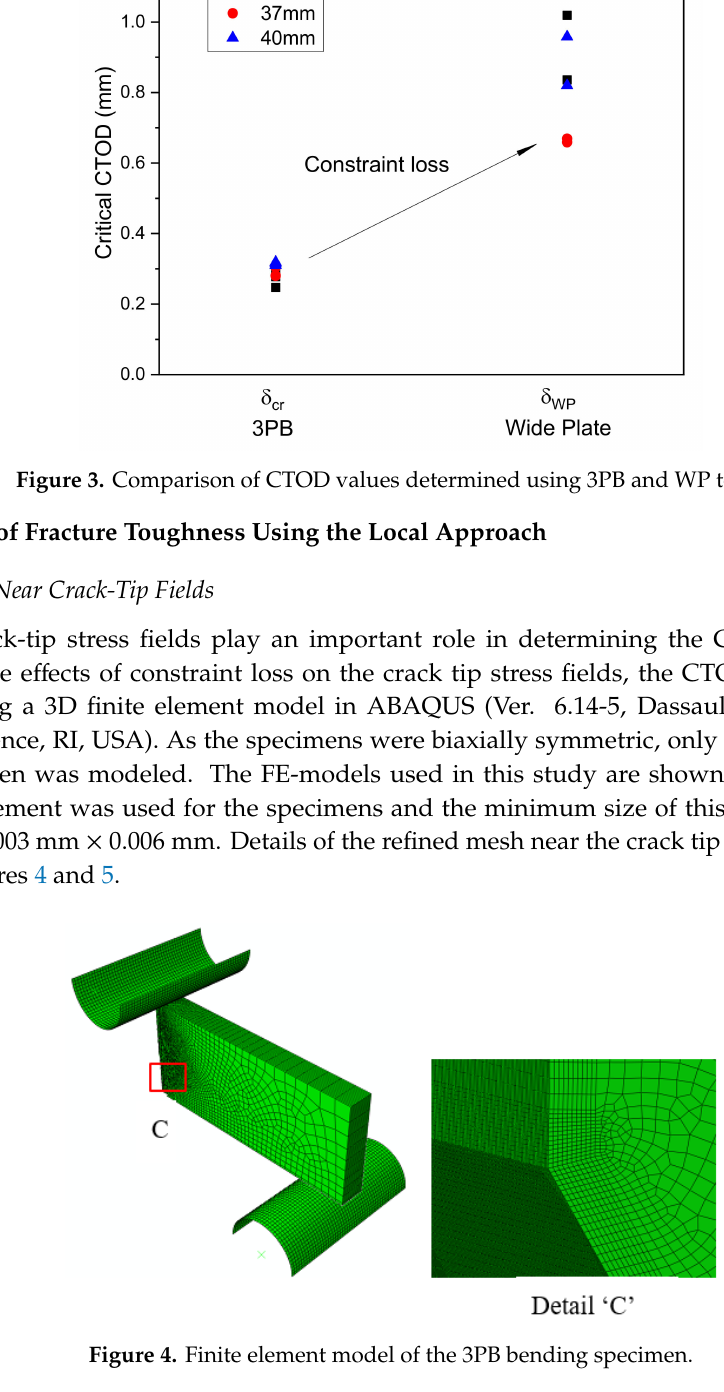
Figure 5. Finite element model of the WP specimen. 0